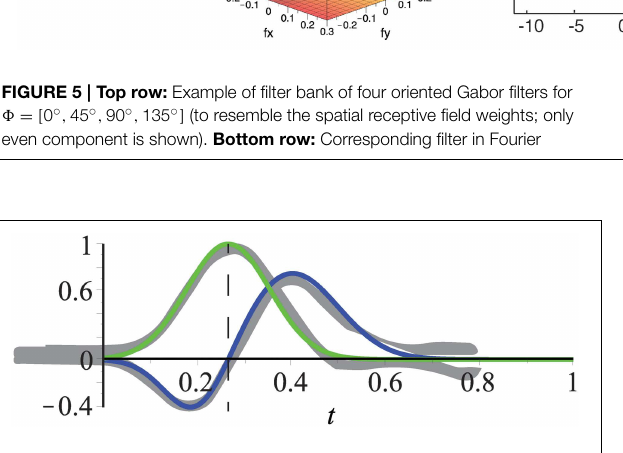
FIGURE 6 | Temporal filters fit experimental data (gray) from De Valois et al. (2000). Kernels consist of one or two Gaussians which define a mono- and bi-phasic temporal filter, respectively. The mean of the mono-phasic kernel has been set to µ bi 1 0 . 2 with the remaining parameters = fitted to the experimental data (see text for details). Dashed line highlights that the peak of the mono-phasic kernel (green) is located at the zero-crossing of the bi-phasic kernel